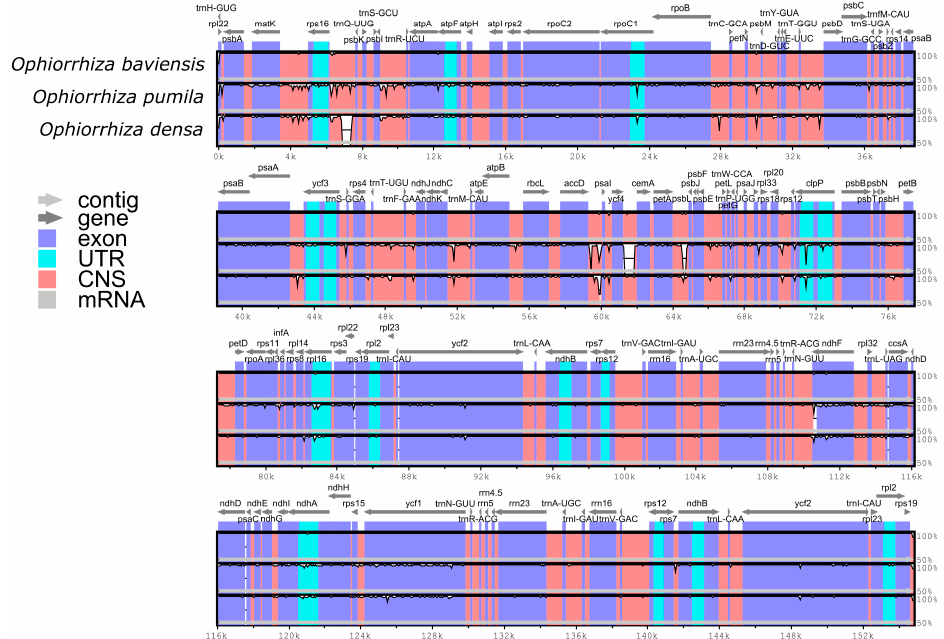
Figure 5. Complete chloroplast genome alignments of the three Ophiorrhiza species. The horizontal axis indicates the coordinates within the chloroplast genome. The vertical scale indicates the percent identity within 50–100%. Annotated genes are displayed along the top.